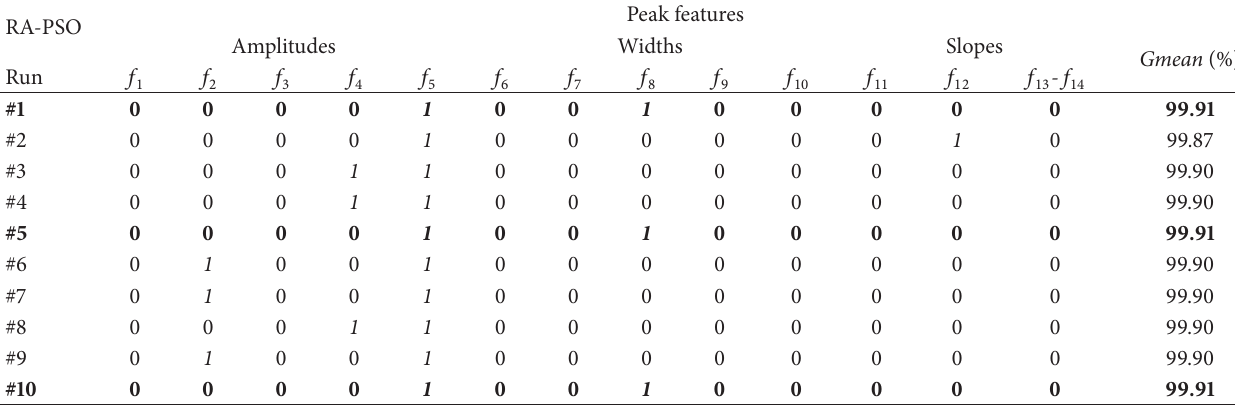
Table 12: Training results: the feature sets of 10 runs using RA-PSO.